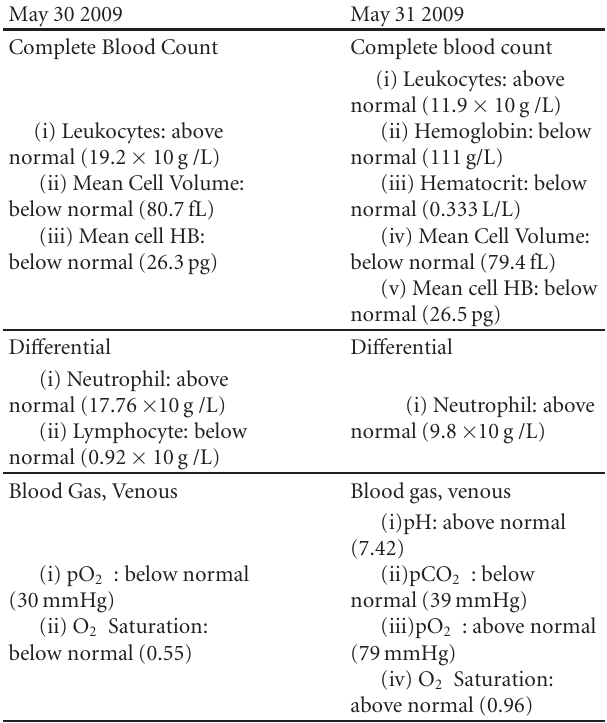
Table 1: Case 1 laboratory results, May 2009.